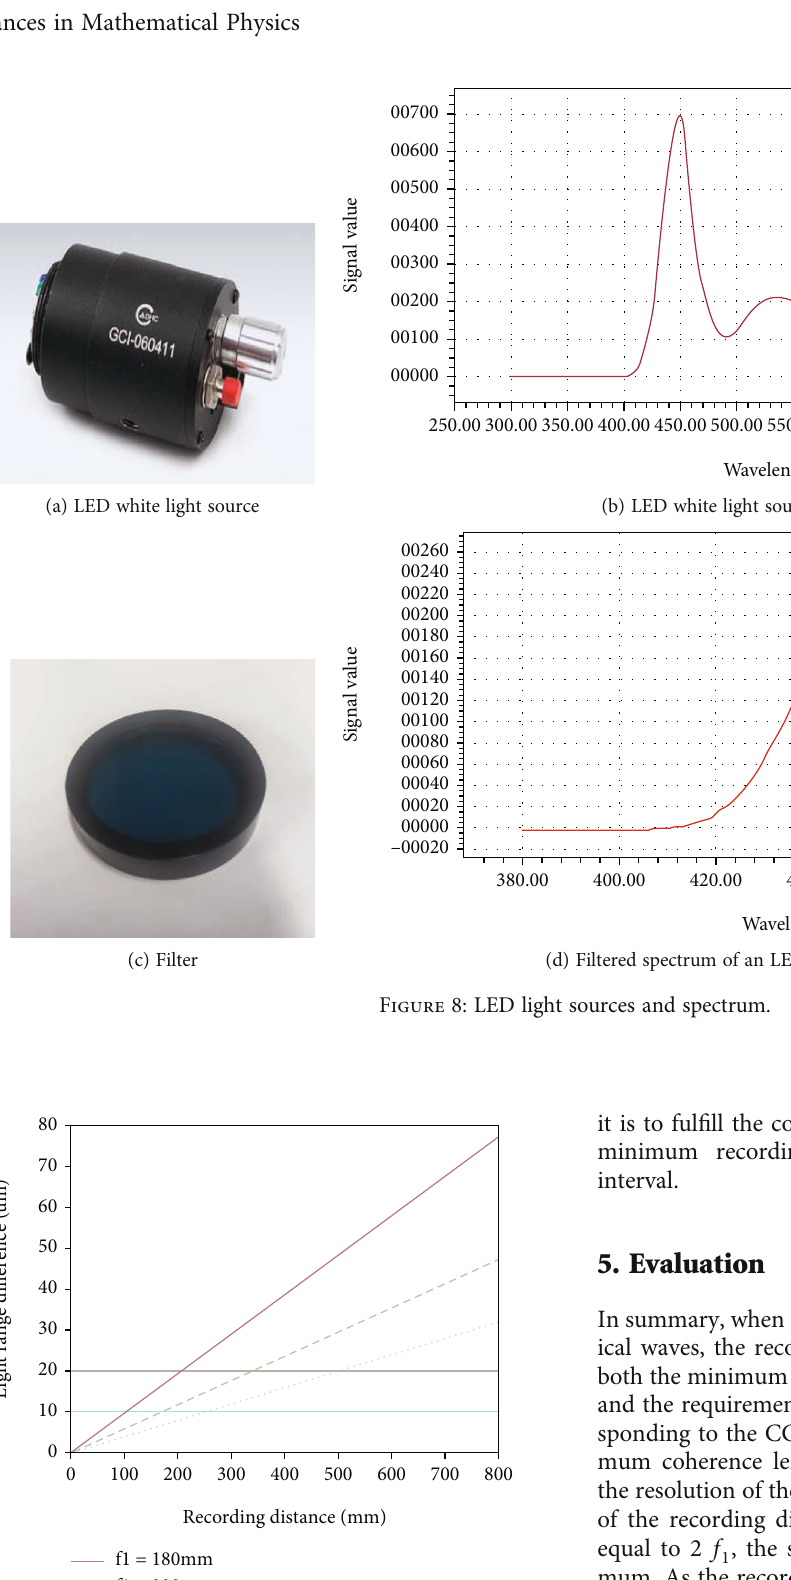
(plane wave plus spherical h